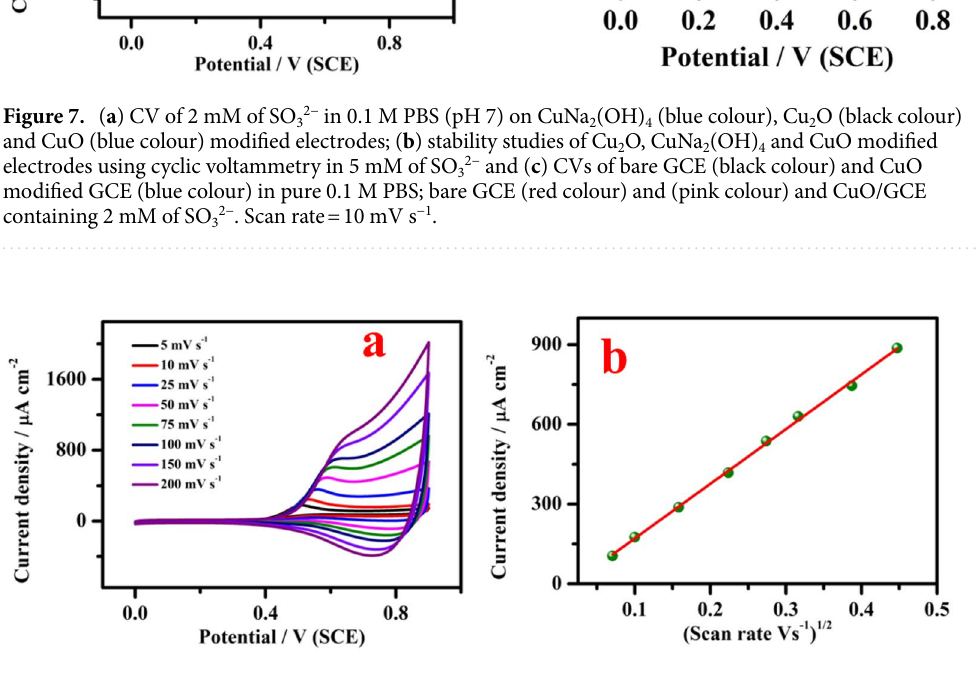
Real sample analysis. For the practical application, CuO/GCE was used to analyze wine samples, which were purchased from local wine shop and used as real sample to detect the presence of SO 32− . Using PBS solution, the wine samples were diluted and the required amount of the sample was injected into the supporting electrolyte without further pre-treatment. The CuO/GCE was used for sensing SO 32− in the wine samples. A characteristic catalytic peak of SO 32− was observed at 0.5 V. Cyclic voltammetric measurement was performed for the estima- tion of SO 32− in the wine sample as shown in Fig. S2a and the corresponding calibration curve is displayed in Fig. S2b. The sensor parameters of real samples obtained are summarized in Table 2. The proposed sensor shows recovery in the range of 99–100.9%, which indicates that the proposed CuO based electrochemical sensing plat- form can be used for the determination of SO 32− in wine samples. Repeatability, stability, fabrication reproducibility and interference studies of CuO/GCE. In order to assess the fabrication reproducibility of proposed sensor, five modified electrodes were fabricated under identical fabrica-